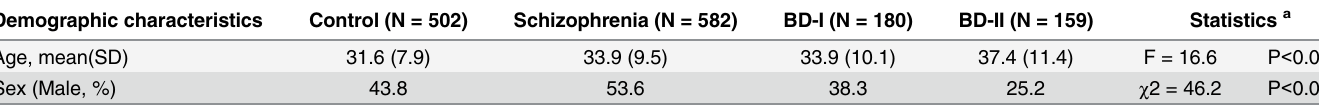
Table 2. Demographic characteristics of the